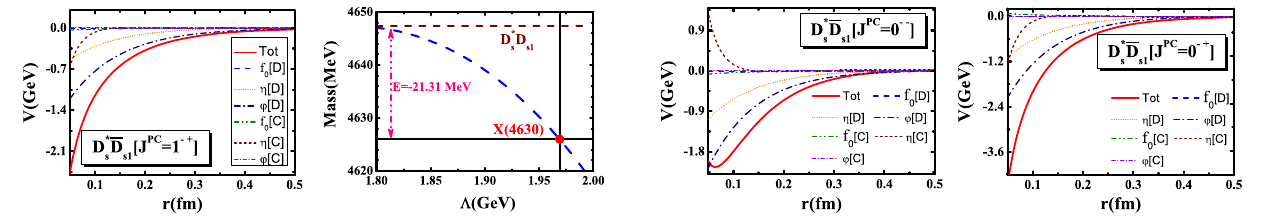
Fig. 2 The r dependenceoftheOBEeffectivepotentialsforthe D ∗ s ¯ D s 1 stateswith J PC =0 −− and 0 −+ . Here, we take the cutoff (cid:10) = 1 . 97 GeV. [D] refers to the direct channel and [C] means the cross channel duce large cutoff value when reproducing the mass of the X ( 4630 )